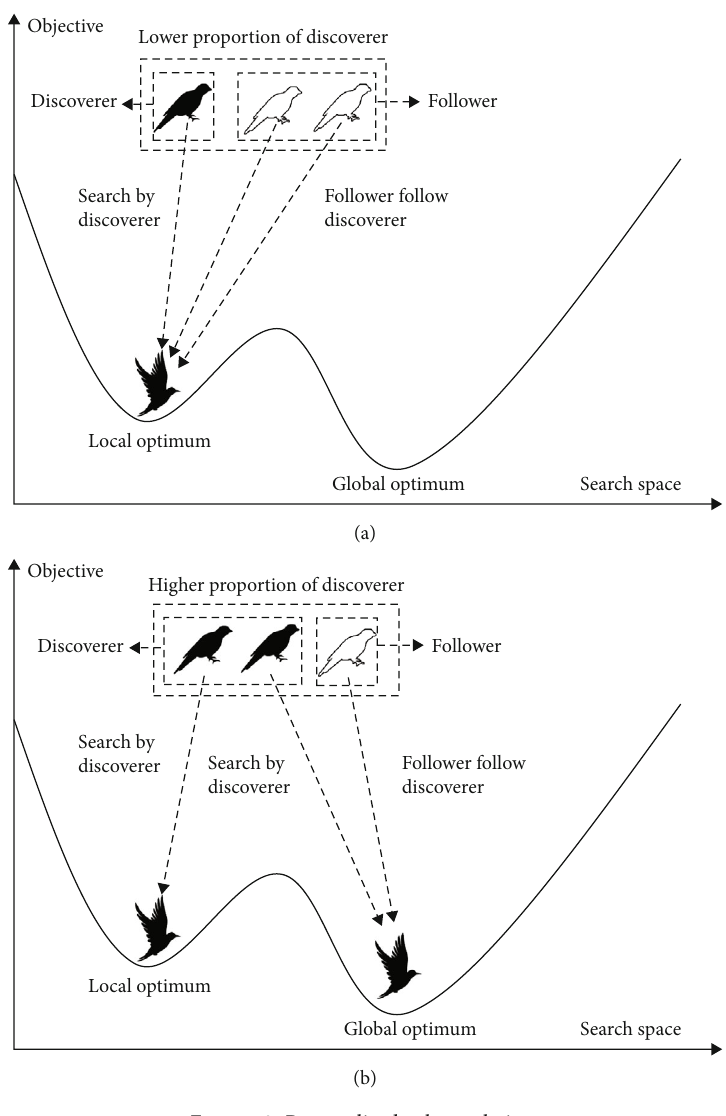
Figure 2: Personalized